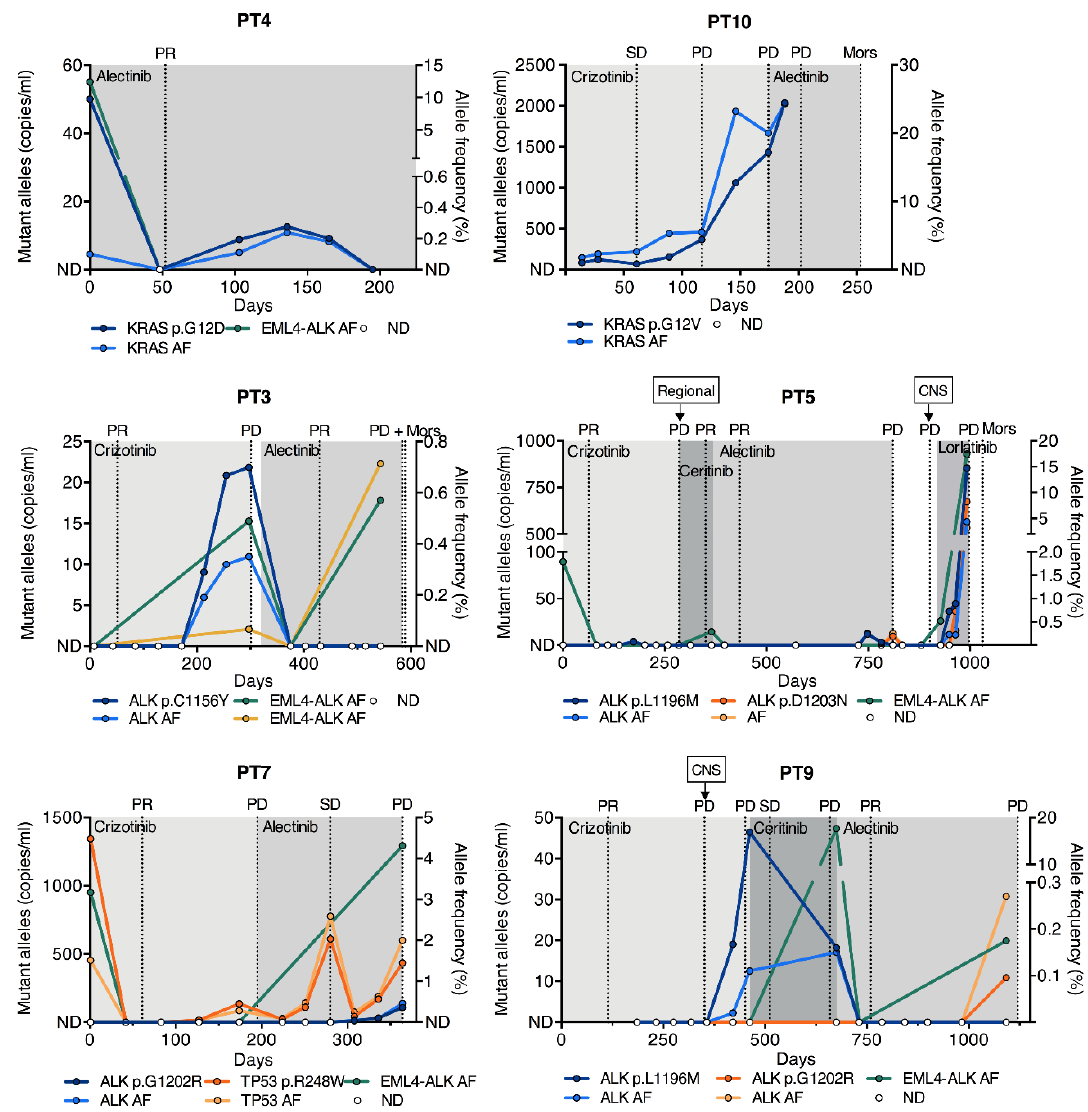
Figure 4. Longitudinal measurements of SNVs. Longitudinal monitoring of SNVs in six patients with ALK, KRAS, and TP53 mutations by ddPCR during ALK TKI treatment. The x -axis indicates the time from the start of the treatment in days. The left y -axis indicates the mutant allele concentration of the SNV in copies / mL plasma, and the right y -axis shows the AF in percent. EML4-ALK rearrangement AFs from NGS analysis are plotted as well. Representative CT scan evaluations are indicated by gridlines, and ALK TKI treatments by shaded areas. PR, partial response; SD, stable disease; Mors, deceased; AF, allele frequency; ND, not detected; CNS, central nervous system; ddPCR, droplet digital PCR.